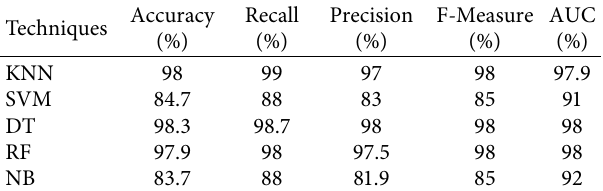
Table 4: Result of ML for selected features by PCA. Table 6: Result of applying the bagging technique to selected features by PCA.